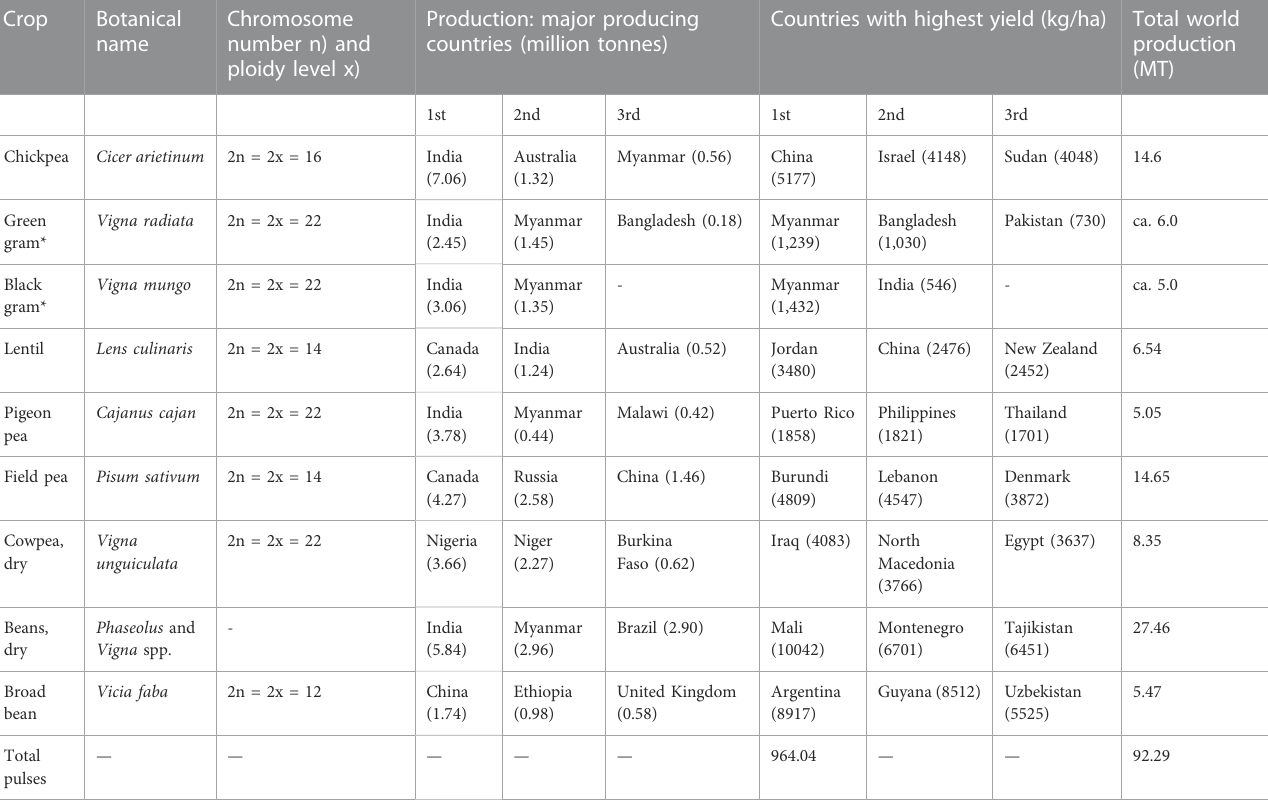
TABLE 1 Information on the production and yield status of the major grain legume crops cultivated worldwide, along with their botanical names and chromosome numbers. Crop Botanical